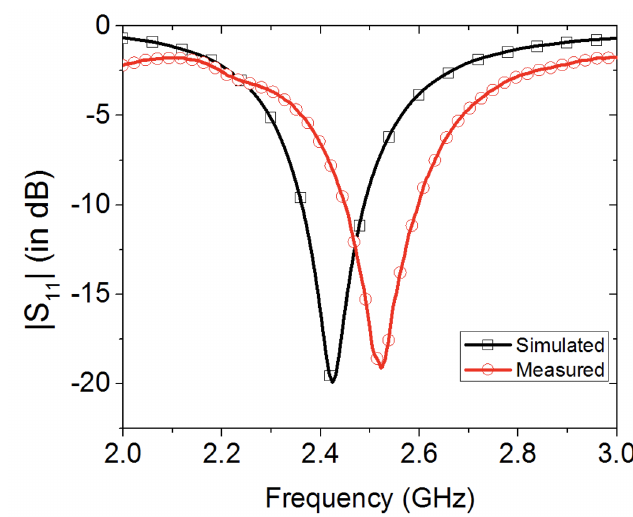
Figure 2. Simulated versus measured reflection coefficient of the wearable loop antenna with loop metallic width of s = 1 mm on textile cotton fabric with permittivity of 1.2, loss tangent of 0.02 and thickness of 0.242 mm.